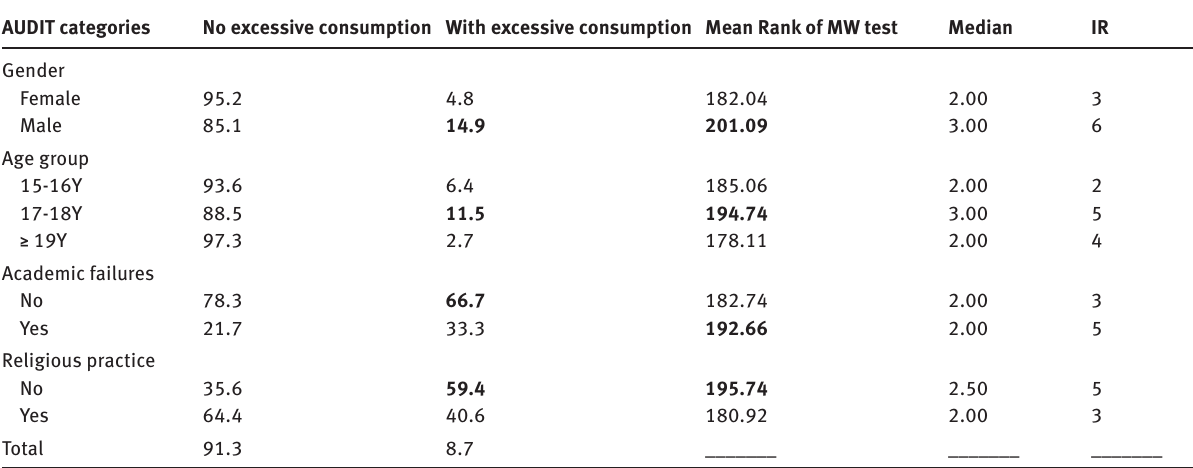
Table 3: Sample distribution regarding AUDIT categories of factors, median and interquartile of ranges and mean rank of MW test (%) N = 378